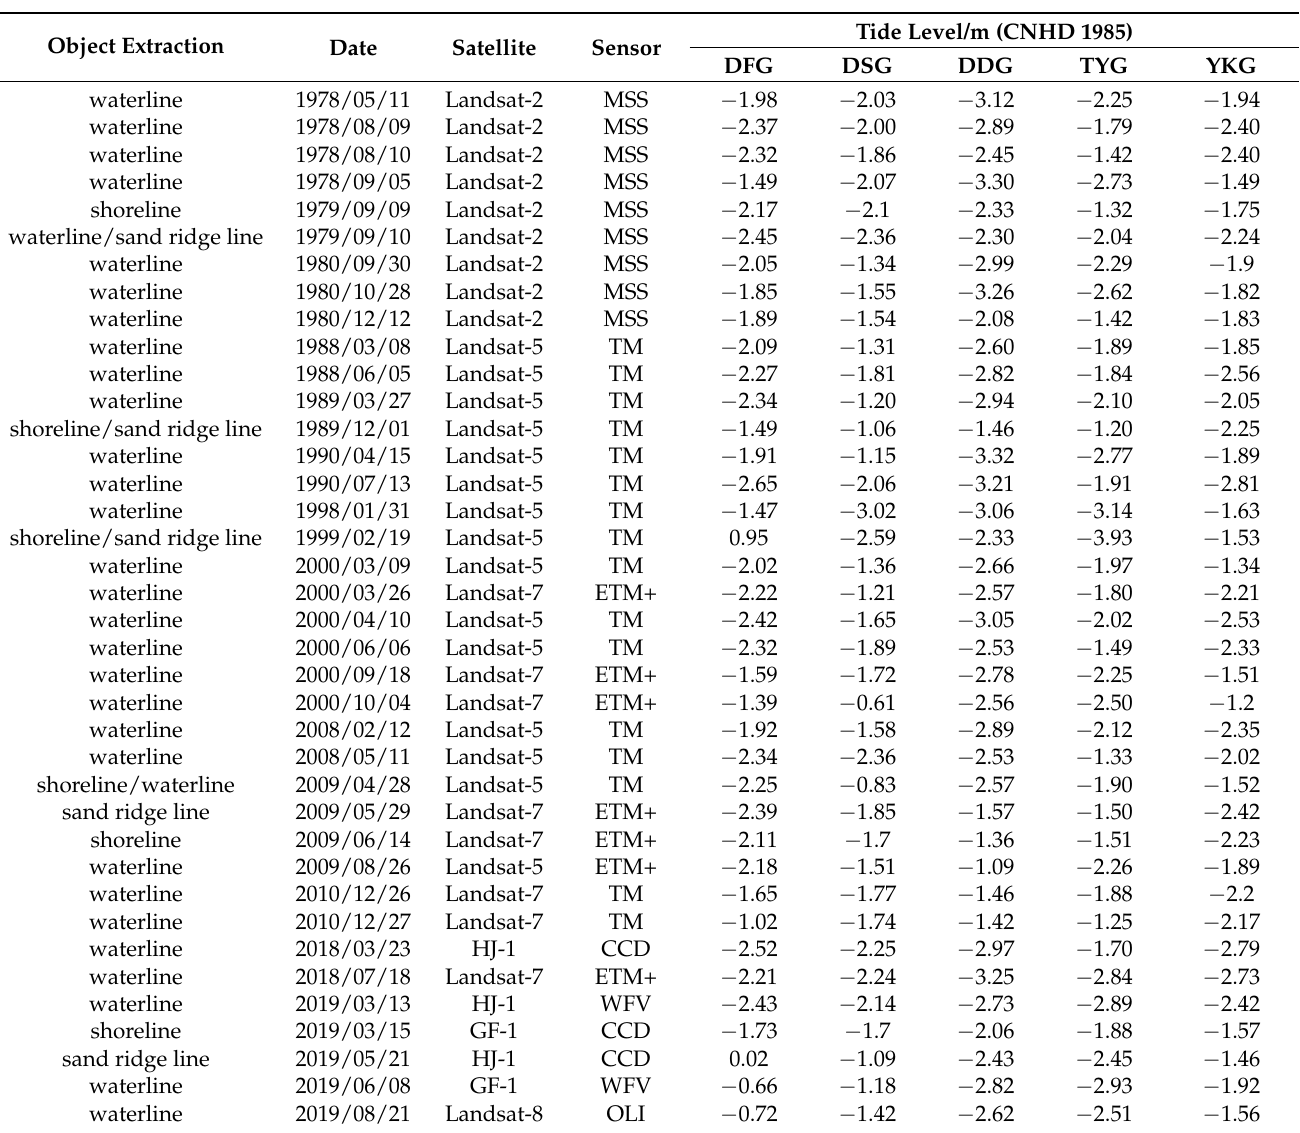
Table 1. Remote sensing images and corresponding tide level